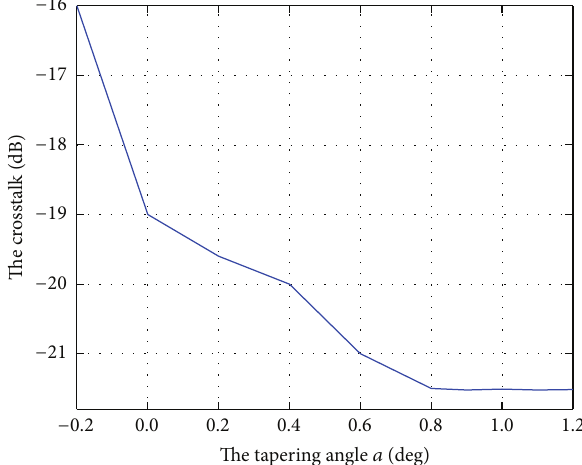
Figure 10: Optical field distribution of a tapered MMI ( 𝑎 = −0.9 ∘